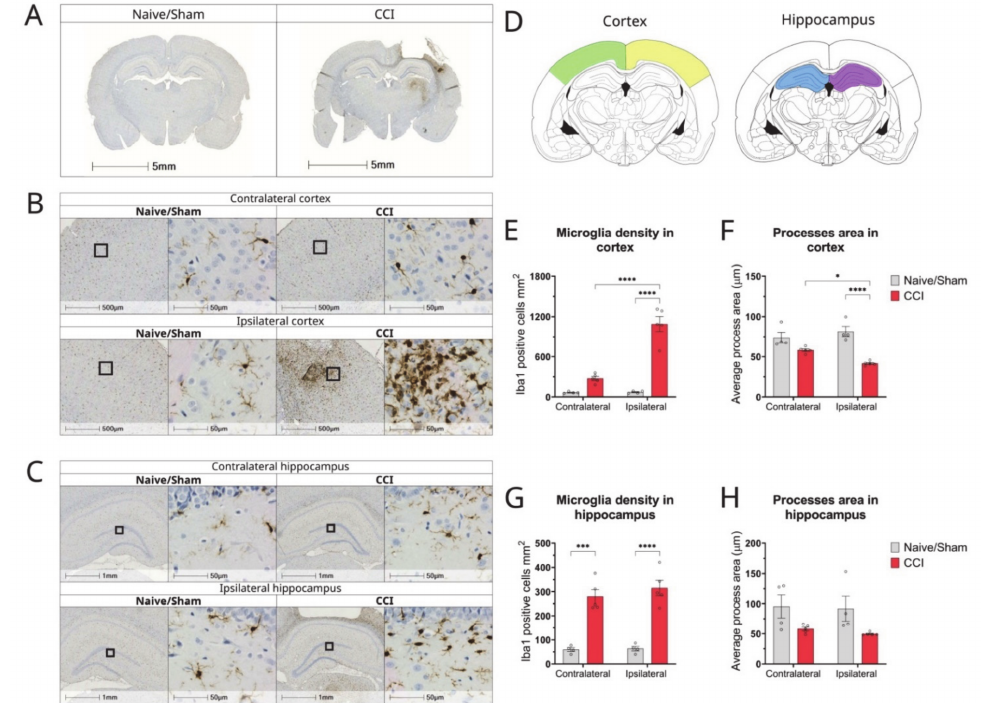
Figure 3. Changes in microglial density, morphology, and distribution in cortex and hippocam- pus of CCI rat brains 2 weeks post-injury. ( A ) Representative whole brain photomicrographs of Iba1 + staining in naïve/control and CCI rat brains; ( B ) Magnified representative images of the cortex of naïve/sham animals and CCI brains from ipsilateral and contralateral sides of the injury; ( C ) Magnified representative images of the hippocampus of naïve/sham animals and CCI brains from ipsilateral and contralateral sides of the injury; ( D ) Brain atlas images, showing areas of cortex and hippocampus analysed; ( E ) Quantification of the microglia count/mm 2 by Iba1 staining in the cortex of CCI and sham/naïve control rats (2-way ANOVA hemisphere F(1,14) = 38.65 p < 0.0001, injury F(1,14) = 86.36 p < 0.0001, interaction F(1,14) = 37.63 p < 0.0001); ( F ) Average process area per microglia in cortex of CCI and naïve/sham rats (2-way ANOVA hemisphere F(1,14) = 1.129 p = 0.3060, injury F(1,14) = 44.53 p < 0.0001, interaction F(1,14) = 8.569 p = 0.0110); ( G ) Quantification of the microglia count/mm 2 in the hippocampus of CCI and sham/naïve control rats (2-way ANOVA hemisphere F(1,14) = 0.631 p = 0.4402, injury F(1,14) = 9 3.32 p < 0.0001, interaction F(1,14) = 0.409 p = 0.5324); ( H ) Average process area per microglia in hippocampus of CCI and naïve/sham rats (2-way ANOVA hemisphere F(1,14) = 0.234 p = 0.6357, injury F(1,14) = 9.955 p = 0.0070, interaction F(1,14) = 0.036 p = 0.8522);. All data are presented as mean ± SEM, n = 4–5 per group. Two-way ANOVA, * p < 0.05, *** p < 0.001; **** p < 0.0001. Mouse brain atlas images were obtained from the Allen Institute